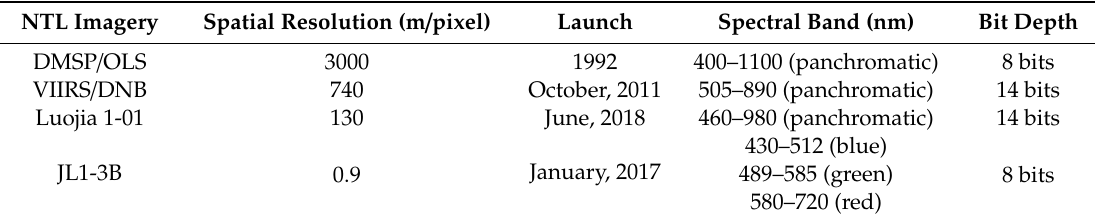
Table 1. Relevant parameters for di ff erent nighttime lights (NTL)